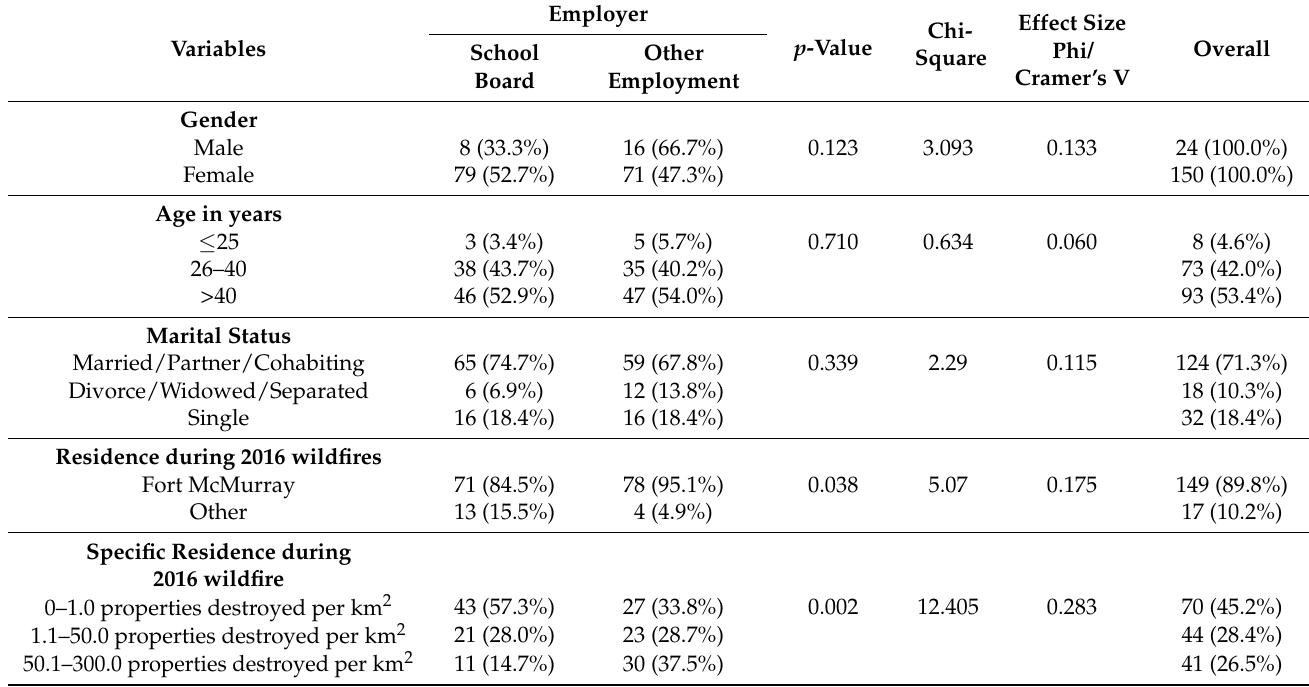
Table 1. Chi-square test of association between employer type, the demographic, and the 2016 wildfire related